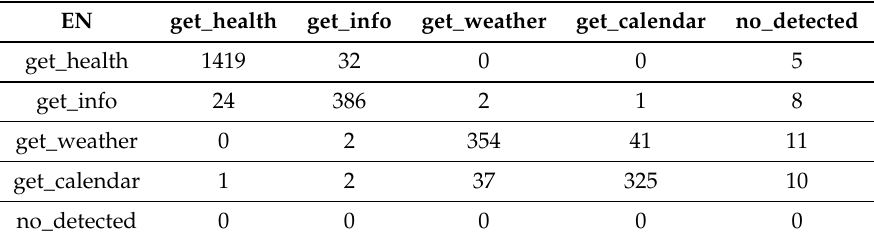
Table 4. Confusion matrix for the intent detection for the English language.